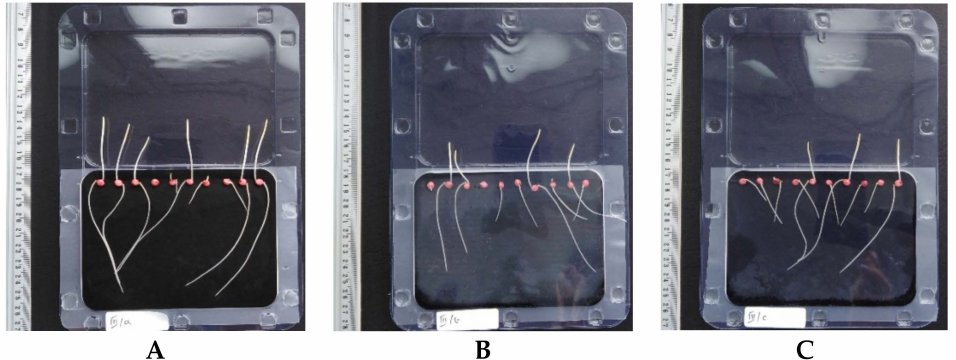
Figure 4. Effect of HAs, nitrogen fertilizer and phosphorus on the growth of Sorghum saccharatum . ( A ) Has. ( B ) nitrogen fertilizer. ( C ) phosphorus